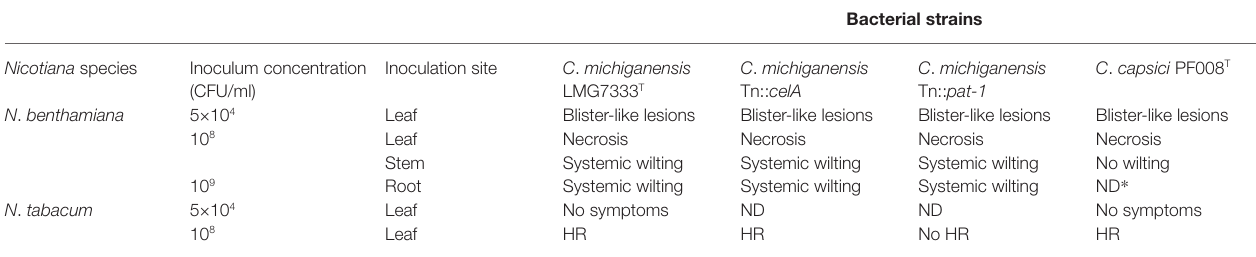
Bacterial strains